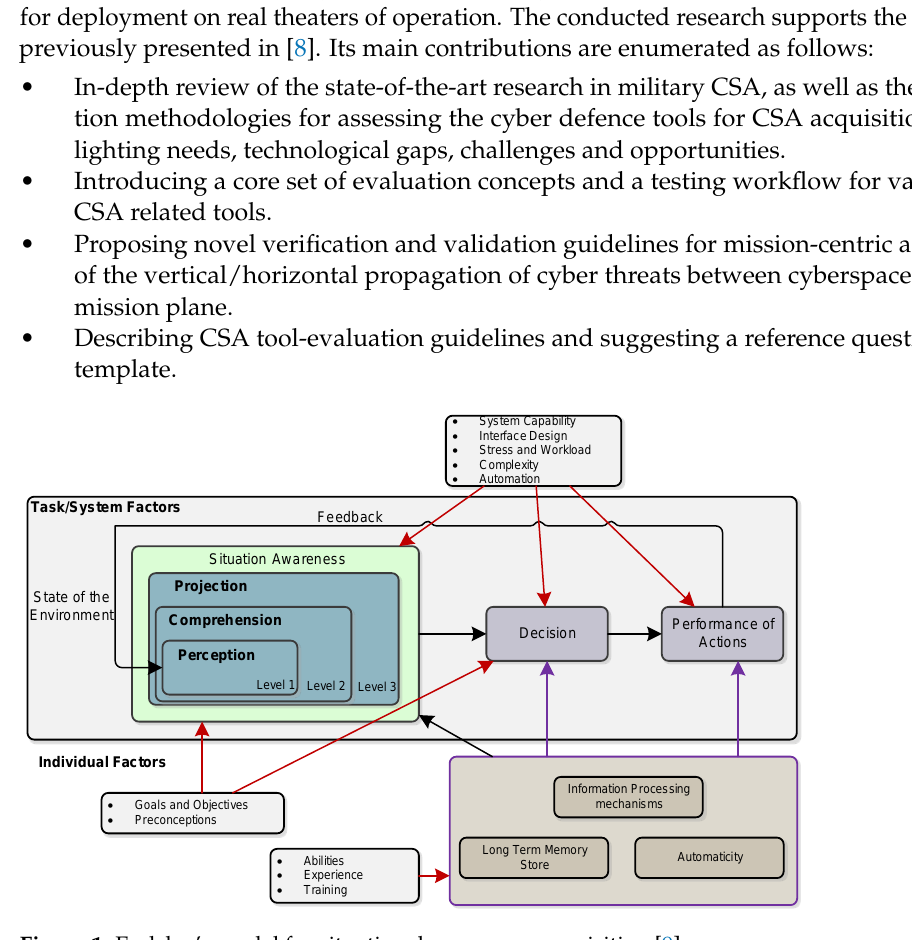
Figure 1. Endsley’s model for situational-awareness acquisition